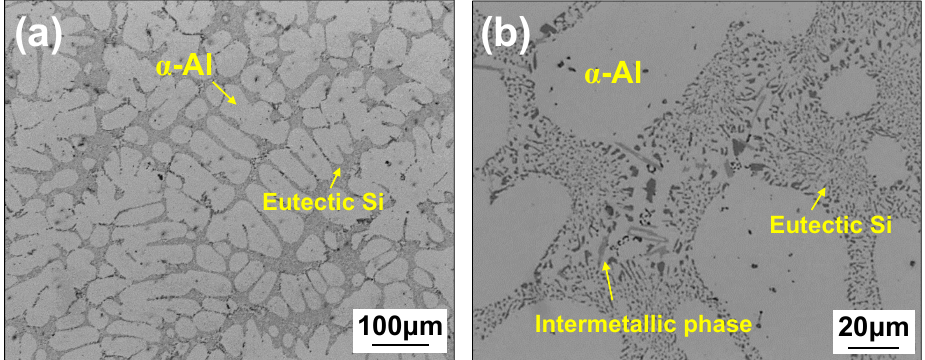
Figure 3. Optical microscope images of ( a ) 100 × magnification and ( b ) 500 × magnification of the CPC A356 specimen in as-cast